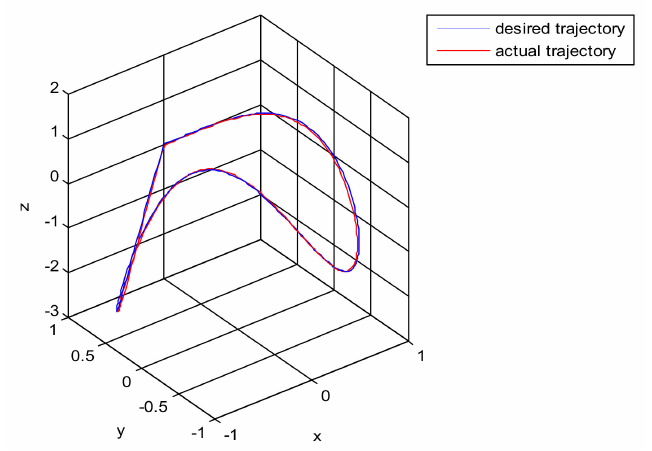
Figure 13. Trajectory tracking of end effector of Baxter’s right arm. (Simulation of robust control algorithm tracking based on state observer).